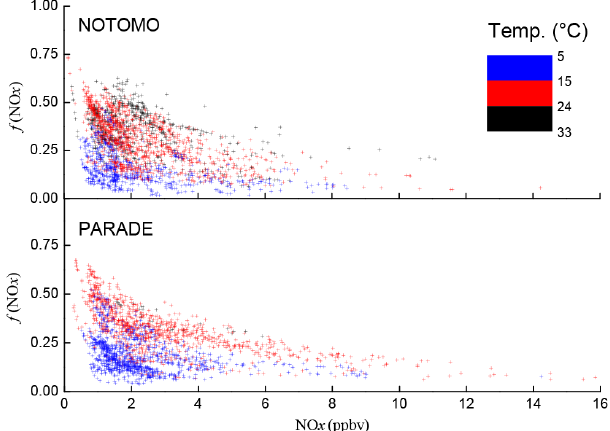
Figure 3. The fraction of NO x sequestered as organic nitrates f (NO x ) = [ (cid:54) PNs] + [ (cid:54) ANs] / ([ (cid:54) PNs] + [ (cid:54) ANs] + [NO x ]) as a function of NO x for the NOTOMO and PARADE campaigns, both colour coded for temperature.